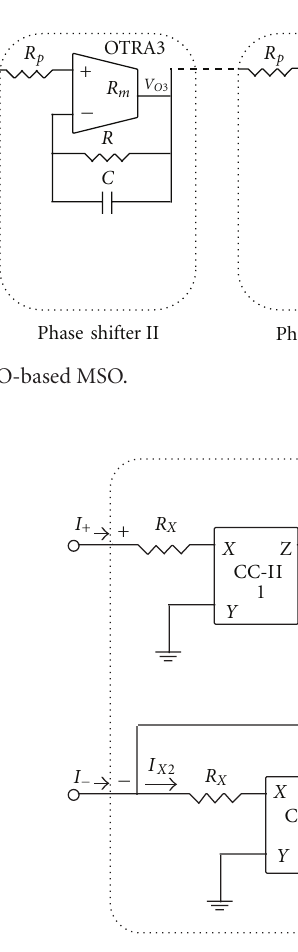
Figure 5: OTRA based on AD844. Figure 6: Equivalent circuit of OTRA constructed with